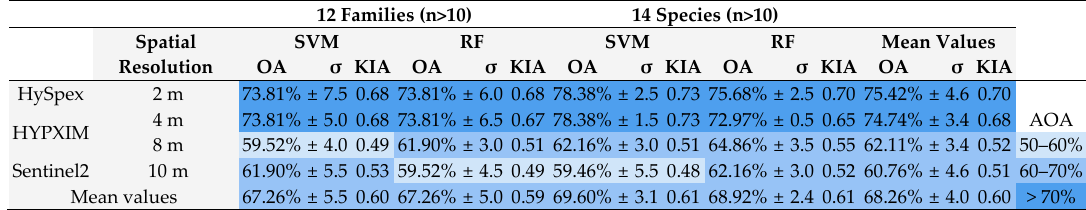
Table 4. Urban tree diversity classification averaged overall accuracies (AOA) and averaged Kappa index of agreement (AKIA) obtained using the 2-folds learning method and applied on each reduced hyperspectral image, and on the original (hyperspectral and Sentinel2) image datasets with RF and SVM according to the four sub-levels for families and species datasets. Table 5. Urban tree diversity classification results obtained using the 10-folds learning method and applied on reduced MNF image datasets, with SVM and RF classifiers according to subsets exhibiting at least 10 individuals per class.